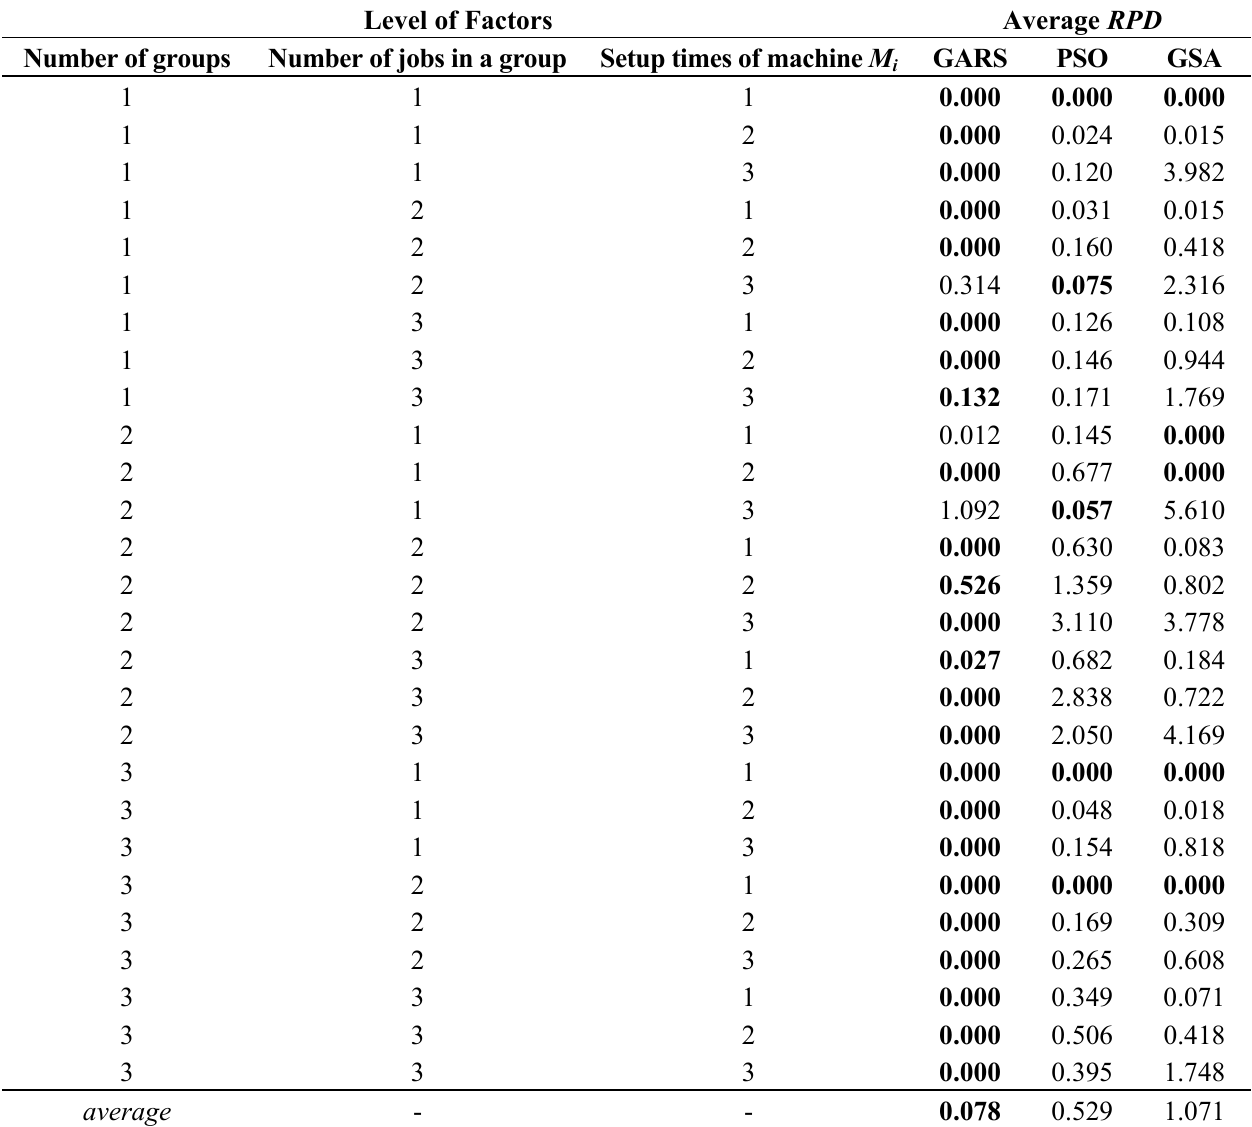
Table 9. Average RPD values for six-machine